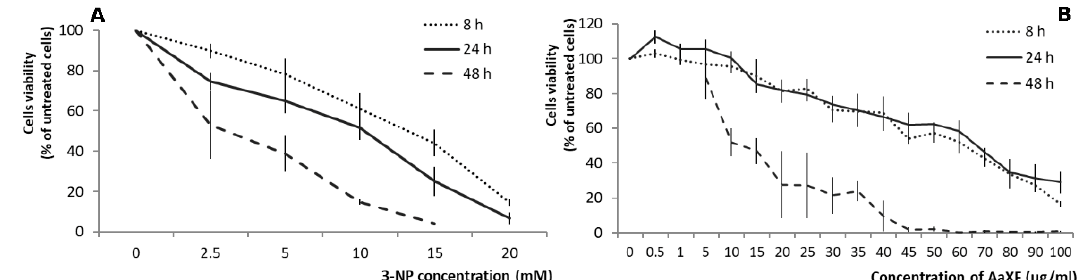
Figure 2. ( A ). Effects of 3-nitropropionic acid (3-NP) on cell viability in PC12 cells. PC12 cells were treated with various concentrations of 3-NP (0, 2.5, 5, 10, 15, and 20 mM) for various times (8 h, 24 h, and 48 h). ( B ) Effects of xanthone-enriched fraction (XF) on cell viability in PC12 cells. PC12 cells were treated with various concentrations of XF (from 0.5 to 100 μ g/mL) for various times (8 h, 24 h, and 48 h). The cell viability was measured using the 3-(4,5-dimethylthiazol-2-yl)-2,5-diphenyl tetrazolium bromide (MTT) assay. The data represent the mean ± SD of reduction in cell viability of three independent experiments.